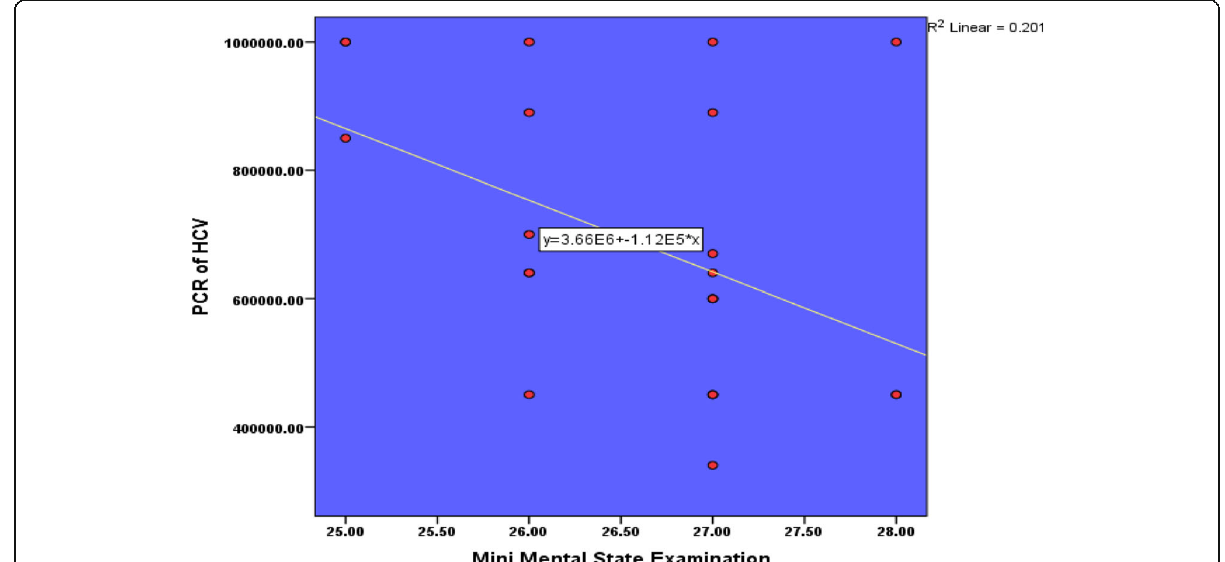
Fig. 4 Mini-mental state score and PCR of HCV in the study group